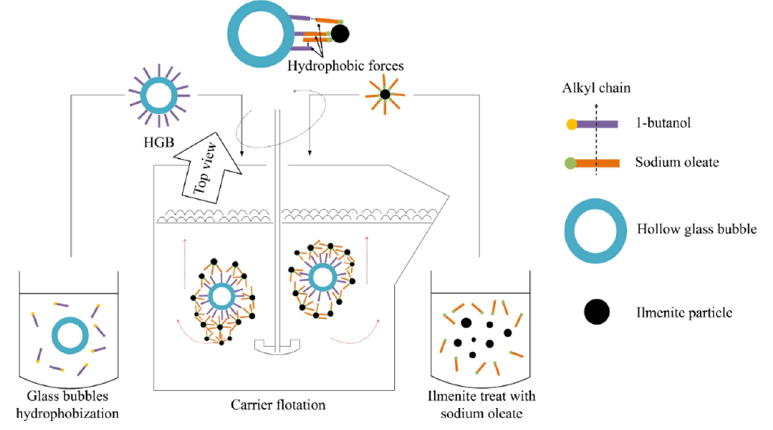
Figure 12. Carrier flotation model of HGB particles promotes ilmenite flotation behavior.